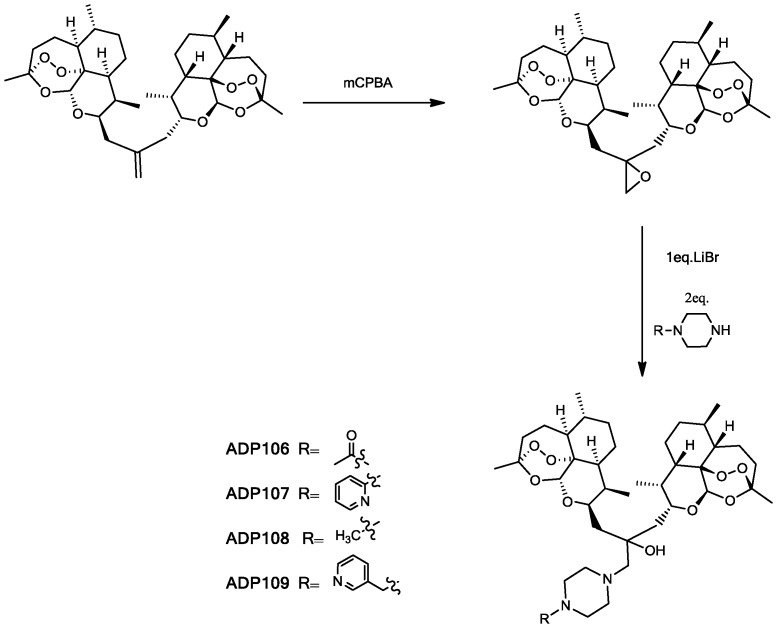
Synthesis of ADPs 106–109.